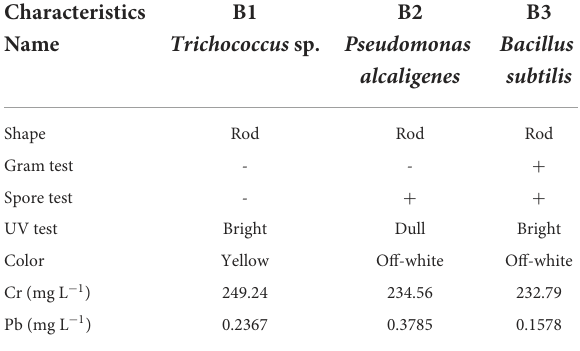
TABLE 2 Morphological and biosorption characteristics of bacterial